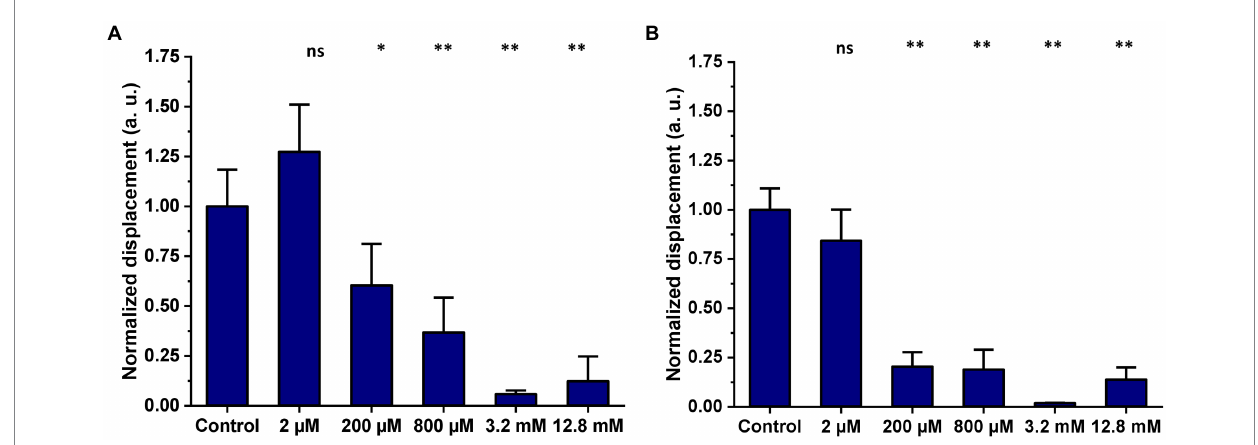
FIGURE 6 Mitochondria isolated from HEK293T were either untreated (control) or exposed to five different concentrations of propionate for 2 h and overnight incubation. Mitochondrial displacement values are expressed in arbitrary units (a. u.) and data are presented as mean ± SEM. Graphs are annotated with p -values from Welch’s ANOVA, followed by Games-Howell’s multiple comparisons test; * p -value < 0.05, ** p < 0.001. Results are representative of three independent experiments. (A) Effect of increasing concentrations of propionate on mitochondrial displacement after a 2-h exposure. The number of mitochondria analyzed in total for each treatment was as follows: control 2 h = 39, 2 μ M = 38, 200 μ M = 31, 800 μ M = 38, 3.2 mM = 55, 12.8 mM = 48. (B) Effect of increasing concentrations of propionate on mitochondrial displacement after overnight exposure. The number of single mitochondria analyzed in total for each treatment was as follows: control overnight = 63, 2 μ M = 47, 200 μ M = 65, 800 μ M = 60, 3.2 mM = 64, 12.8 mM =